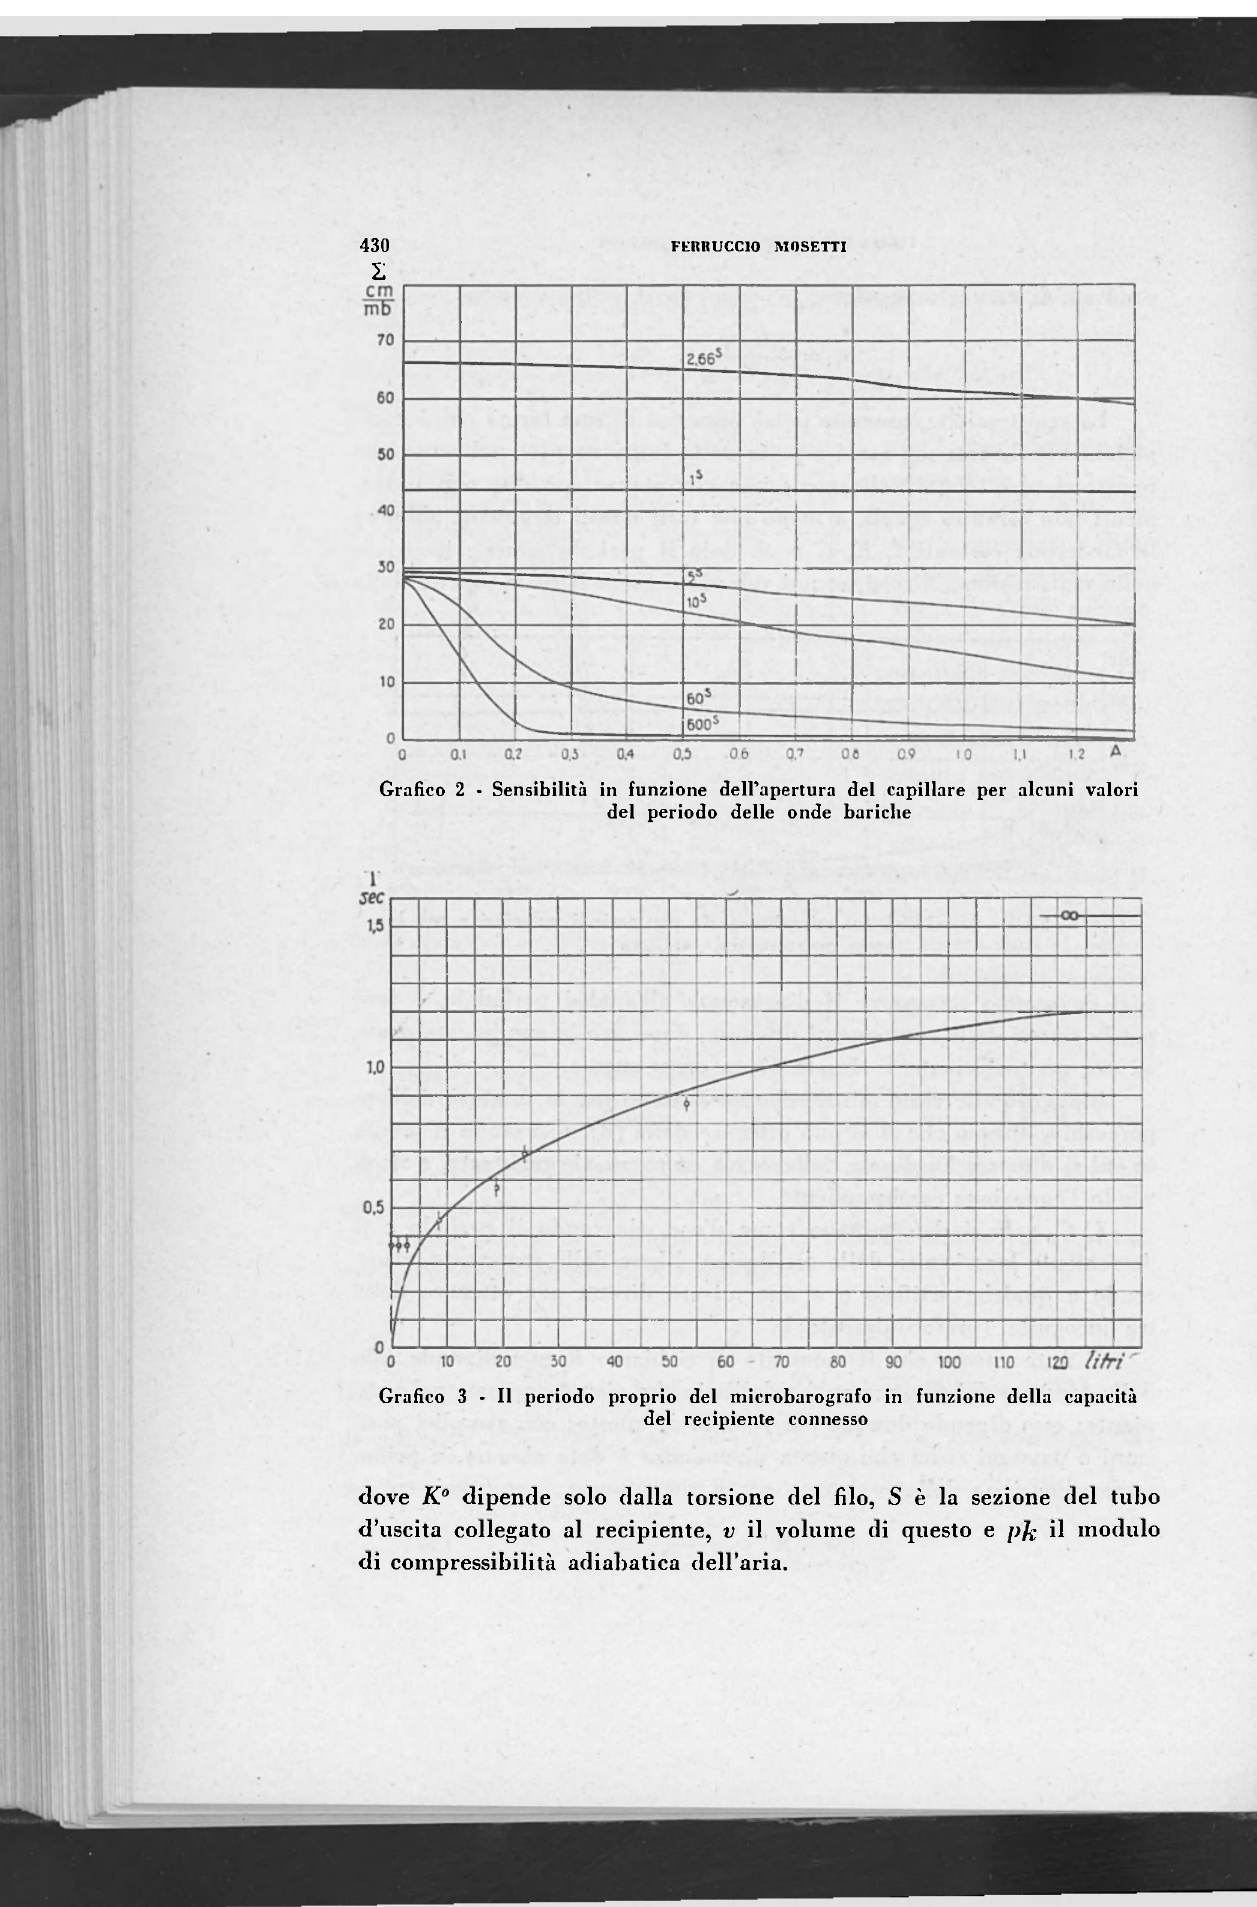
di compressibilità adiabatica